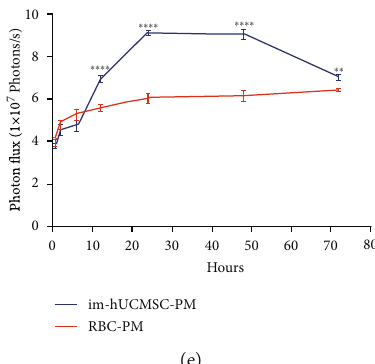
Figure 7: (a) – (c) Cellular uptake of PM and expression of tumor-homing molecules. (d) – (e) Biodistribution of im-MSCs PM after intravenous (IV) injections. (a) IF staining of ATP1A1 (red) in U87 and U251, PM marked with DIO (green), magni fi cation, × 200. Scale bar, 50 μ m. (b) Flow cytometry showing the uptake curve of MSC-PM by U87 and U251. (c) Real-time reverse transcription-PCR (RT- PCR) detection of CXCR4 and SELPLG mRNA expression in hADSCs and im-hADSCs of di ff erent PDs. The results are presented as the mean ± SD of biological triplicate assays. ∗ P < 0 : 05 . (d) Representative IVIS luminescence imaging at di ff erent time points (0.5 hours, 2 hours, 6 hours, 12 hours, 24 hours, 48 hours, and 72 hours) after mice bearing gliomas were injected with cell membranes (im- hUCMSC-PM or RBC-PM). (e) The fl uorescence signal intensity of the mice. The results are presented as the mean ± SD of biological triplicate assays. ∗ P < 0 : 05 , ∗∗ P < 0 : 01 , ∗∗∗ ∗ P < 0 : 0001 . ns: not signi fi cant. IF: immuno fl uorescence; PD: population